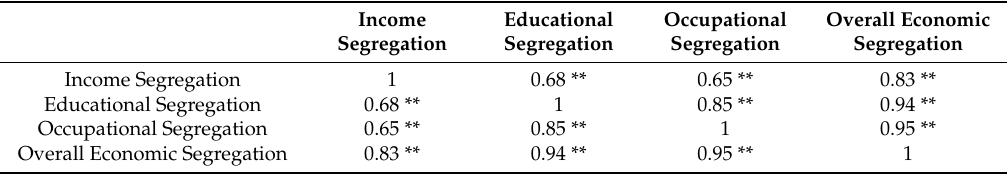
Table 1. Correlations for the Various Economic Segregation Indexes.